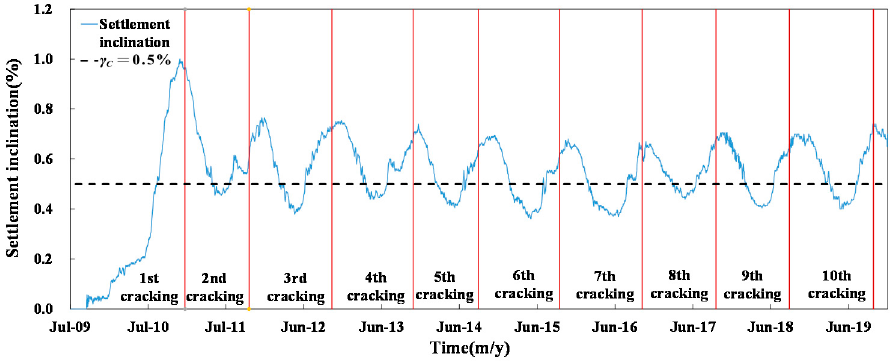
Figure 11. The time series of crest settlement inclination around dam axis.